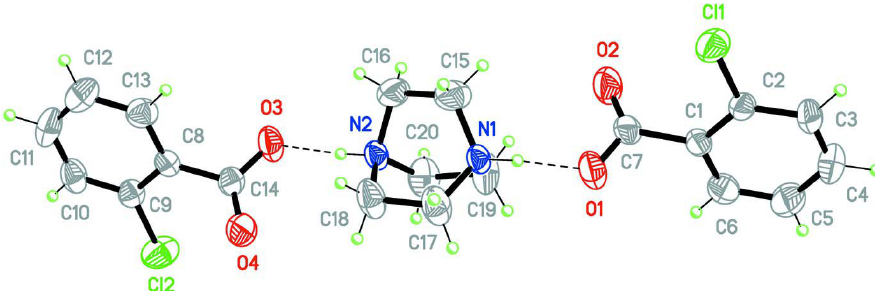
Figure 1 Molecular structure of the title compound showing displacement ellipsoids at the 50% probability level for non-H atoms. The dashed lines denote N + —H···O - hydrogen bonds.